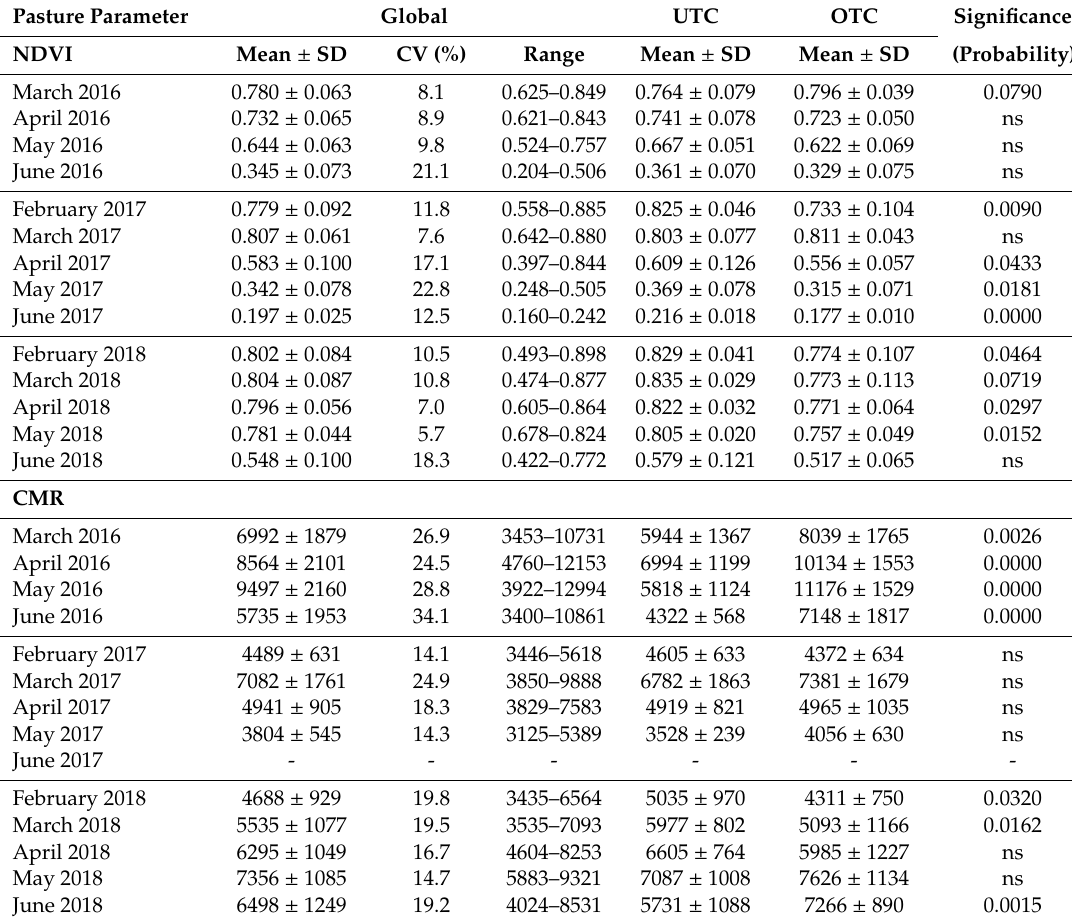
Table 6. Normalized di ff erence vegetation index (NDVI), measured by OptRx sensor, and corrected meter readings (CMR), measured by Grassmaster II probe, of the studied field for each sampling date: Global (all sampling points), UTC (12 sampling points under tree canopy), and OTC (12 sampling points outside tree